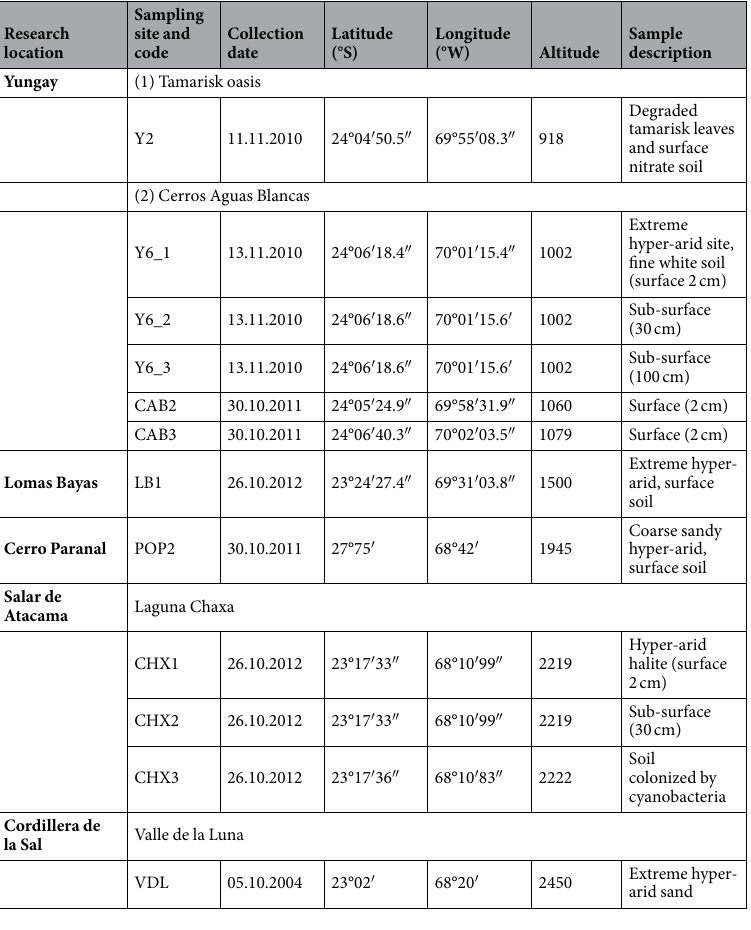
Table 3. Sampling